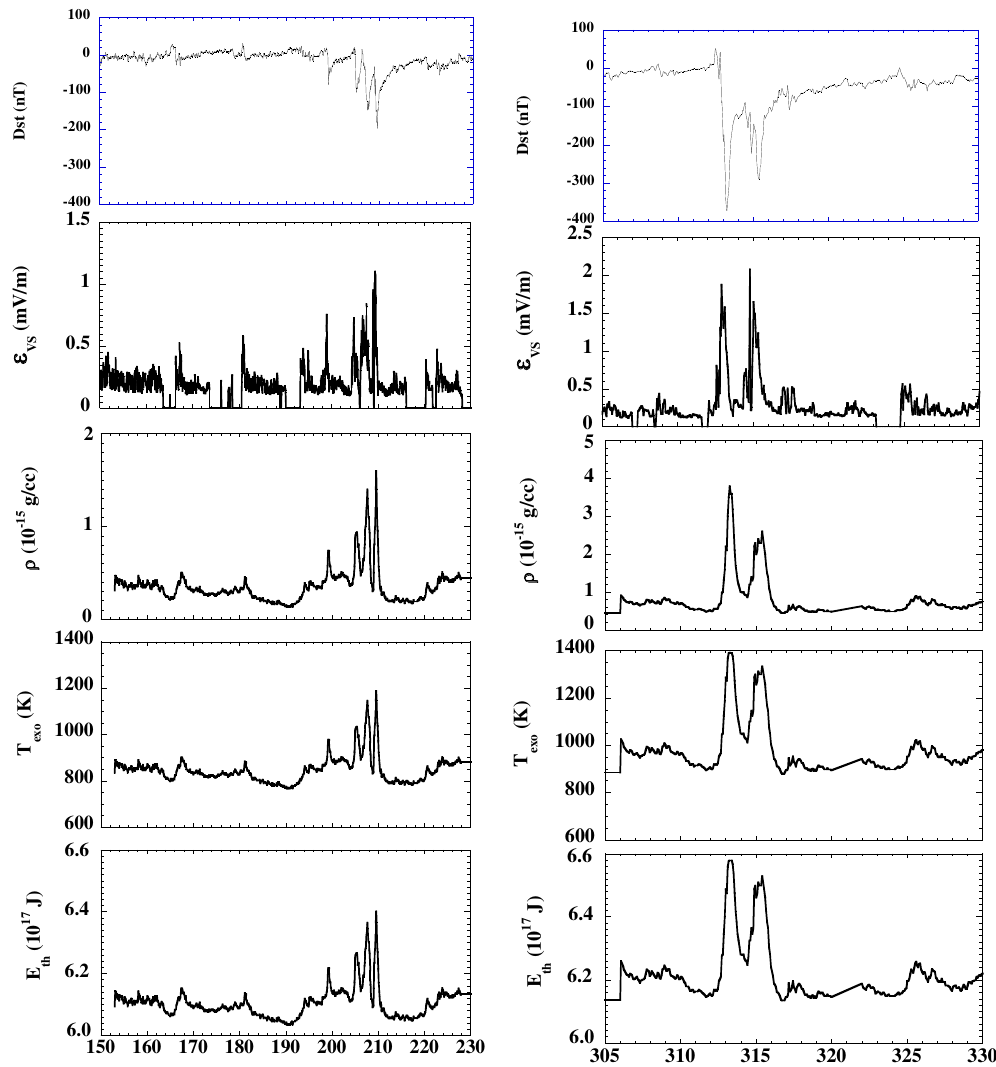
Fig. 5. Geophysical parameters and thermospheric responses plotted as functions of time for (a) Julian days 150 to 230 and (b) 306 to 330, 2004. From top to bottom the traces show the histories of the D st index, ε VS , GRACE measurements of the orbit-averaged density, exospheric temperature and thermospheric